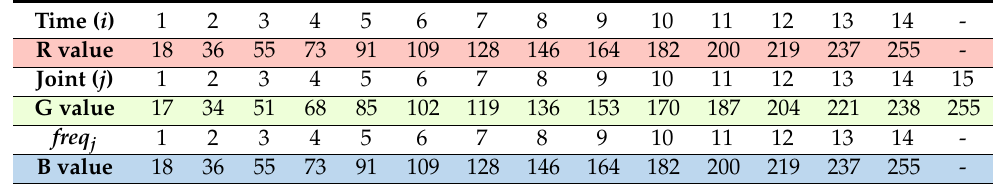
Table 1. RGB values of markers and their indices ( i , j , and freq j ).